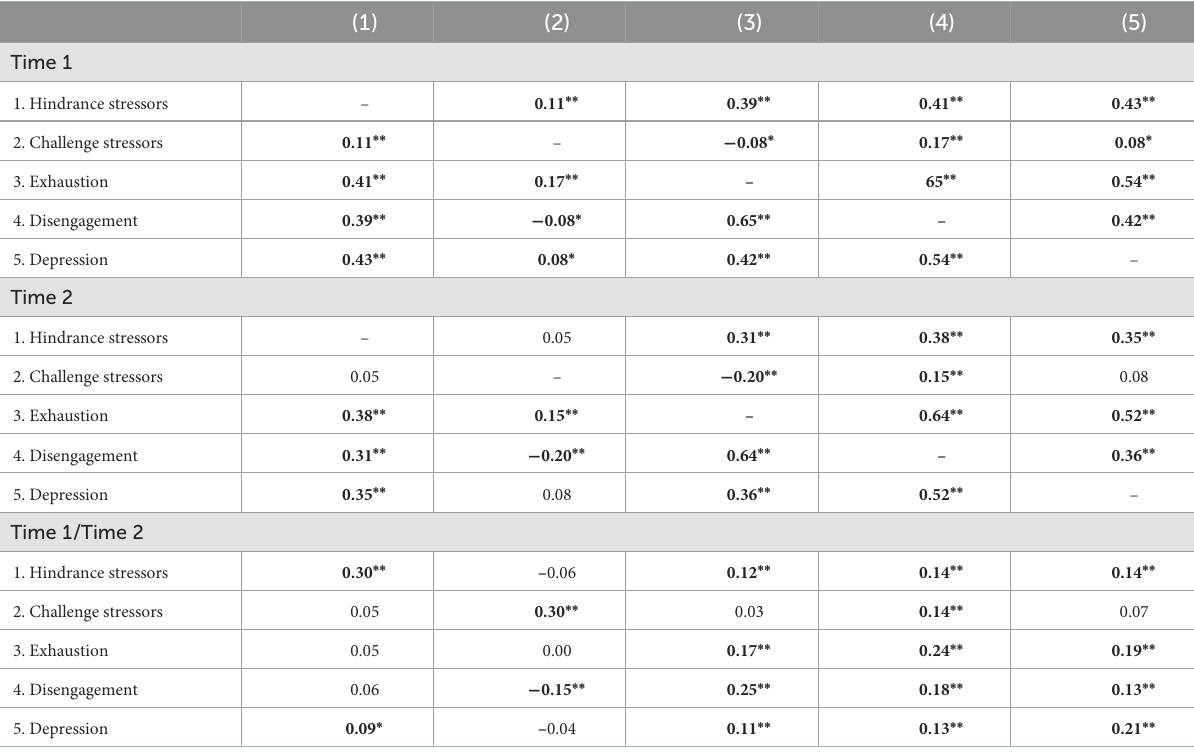
TABLE 2 Zero-order correlational coefficients for study variables separately for measurement occasions and across